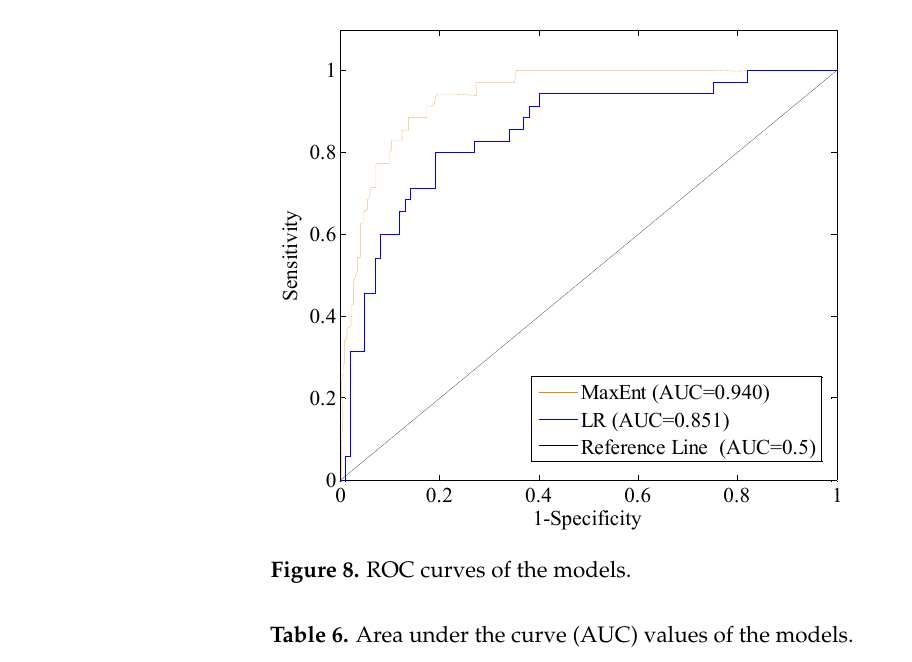
17 of 24 Figure 7. Area percentage of different landslide susceptibility zones within the research region using the models. Table 5. Percentage of landslide areas in each landslide susceptibility class. Landslide Susceptibility Class